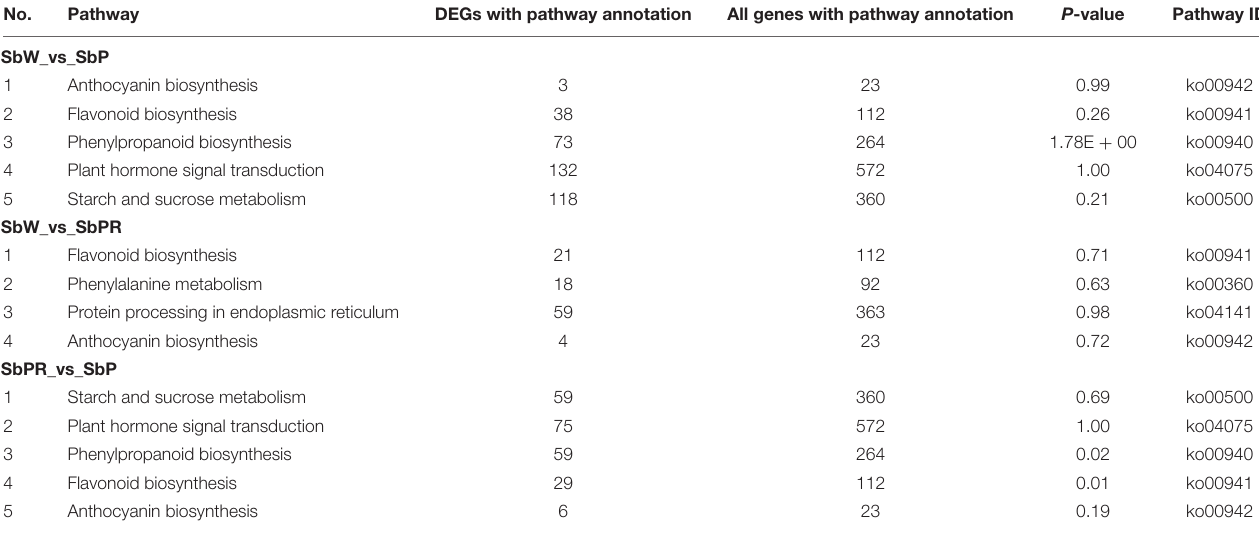
TABLE 2 | Significant enrichment in KEGG pathways among SbW, SbPR, and